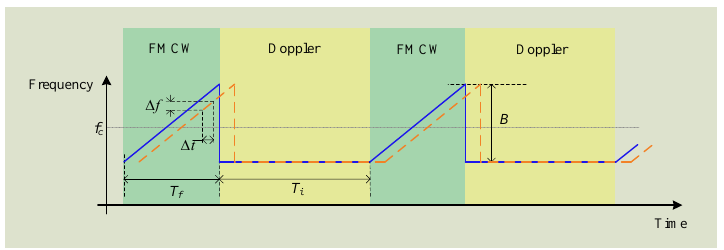
Figure 16. Transmitted signal of the FMCW-interferometry radar.